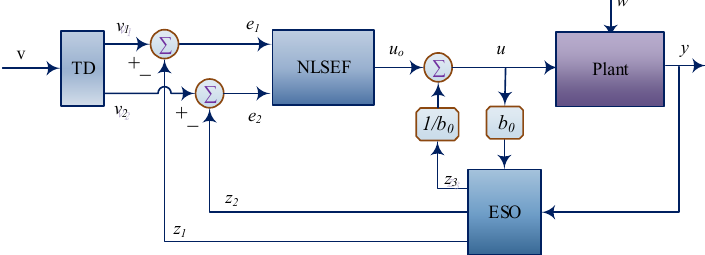
5 of 19 Figure 3. Curves of power coefficient (cid:1829) (cid:3017) ((cid:2019). (cid:2010)) . Nonlinear wind turbine model is shown in a generalized nonlinear form as follows [43]: (cid:1850)(cid:4662) = (cid:1833)((cid:1850)) + (cid:1828)(cid:1873) = (cid:1743)(cid:1742)(cid:1742)(cid:1742)(cid:1742)(cid:1742)(cid:1742)(cid:1742)(cid:1742)(cid:1741)(cid:1842) (cid:3045) ((cid:1876) (cid:2869) . (cid:1876) (cid:2872) . (cid:1848)) (cid:1876) (cid:2869) (cid:1836) (cid:3045) − (cid:1876) (cid:2869) (cid:1830) (cid:3046) (cid:1836) (cid:3045) + (cid:1876) (cid:2870) (cid:1830) (cid:3046) (cid:1840) (cid:3034) (cid:1836) (cid:3045) − (cid:1876) (cid:2871) (cid:1837) (cid:3046) (cid:1836) (cid:3045) (cid:1876) (cid:2869) (cid:1830) (cid:3046) (cid:1840) (cid:3034) (cid:1836) (cid:3034) − (cid:1876) (cid:2870) (cid:1830) (cid:3046) (cid:1840) (cid:3034)(cid:2870) (cid:1836) (cid:3034) + (cid:1876) (cid:2871) (cid:1837) (cid:3046) (cid:1840) (cid:3034) (cid:1836) (cid:3034) − (cid:1846) (cid:3034) (cid:1836) (cid:3034) (cid:1876) − (cid:1876) (cid:2870) (cid:1840) (cid:3034) − 1 (cid:2028) (cid:3081) (cid:1876) (cid:2872) (cid:1746)(cid:1745)(cid:1745)(cid:1745)(cid:1745)(cid:1745)(cid:1745)(cid:1745)(cid:1745)(cid:1744) + (cid:1743)(cid:1742)(cid:1742)(cid:1742)(cid:1741) 0 0 0 1 (cid:2028) (cid:3081) (cid:1746)(cid:1745)(cid:1745)(cid:1745)(cid:1744) (cid:1873) (6) The state vector (cid:1876) , control input (cid:1873), and nonlinear vector (cid:1833)((cid:1850)) are defined as: (cid:1850) = (cid:4670)(cid:2033) (cid:3045)